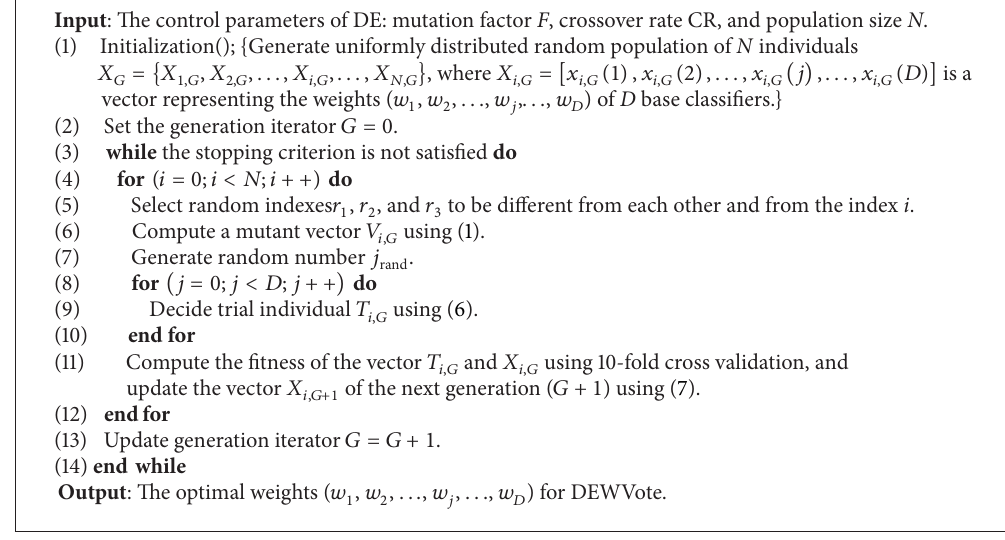
Algorithm 1: DE algorithm for DEWVote’s model selection.